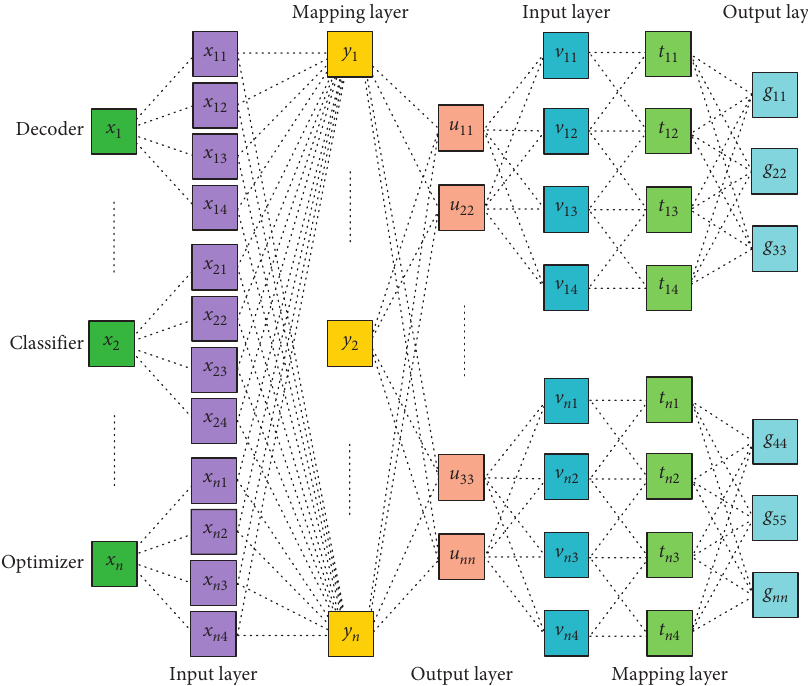
Figure 1: Classification model for English grammar error correction